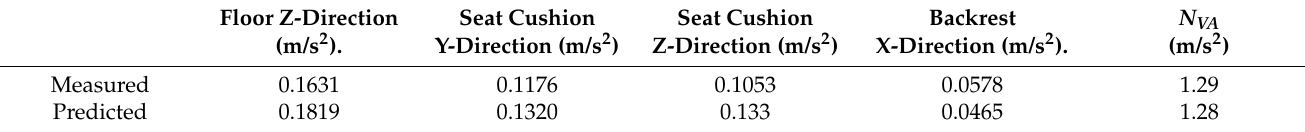
Table 4. Weighted r.m.s. acceleration and predicted ride comfort indicator N VA.